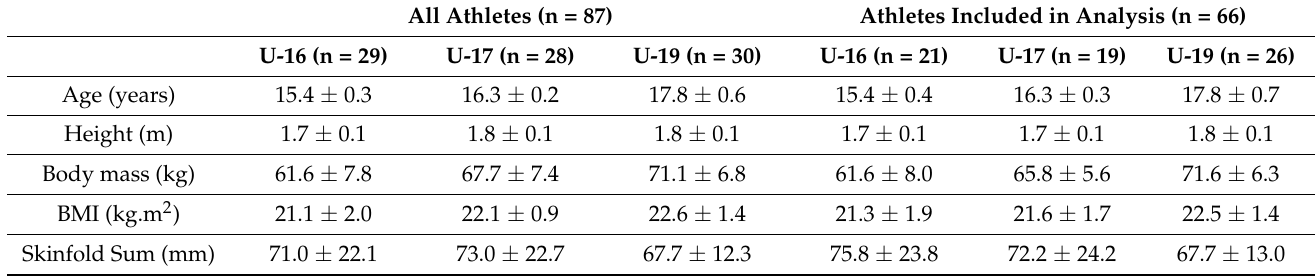
Table 1. Mean and standard deviation of demographic and anthropometric measures for each age